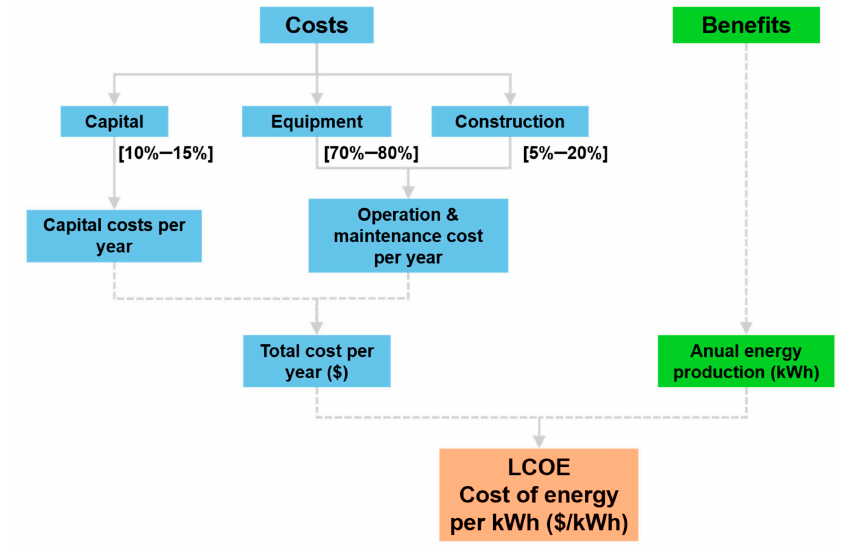
Figure 19. The economics of wind energy. Fixed and variable expenses of operation and maintenance (O&M) account for a substantial portion of the total lifetime cost of ownership (LCOE) of wind generation. Costs associated with operations and maintenance (O&M) may account for anywhere from 11 percent to 30 percent of onshore wind LCOE, and they usually account for 20 percent to 25 percent of the overall levelised cost of energy of contemporary wind generating systems [190]. When wind farm promoters signed complete operation and maintenance contracts with wind turbine manufacturers years ago, they were certain that technologists would offer the greatest degree of development in the maintenance of their